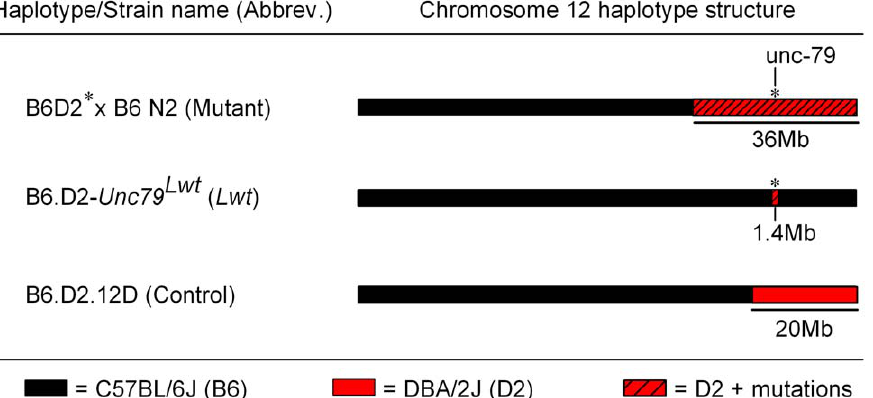
Figure 2. Chromosome 12 haplotype structure of animals used for behavioral testing. B6:D2* 6 B6 N2 (Mutant) mice harbor the mutagenized D2 chromosome 12 across the 95% confidence interval (between D12Mit158 and D12Mit263). The rest of the genome is a mixed B6 and D2 genetic background. Lwt and Control (see [30]) mice are congenic strains on a pure B6 genetic background. Lwt / + and Control/ + males were backcrossed to either B6 or D2 females to produce populations for behavioral testing. B6 chromosomal DNA is represented in black, D2 chromosomal DNA represented in red, and mutagenized D2 chromosomal DNA is represented by hatched red.